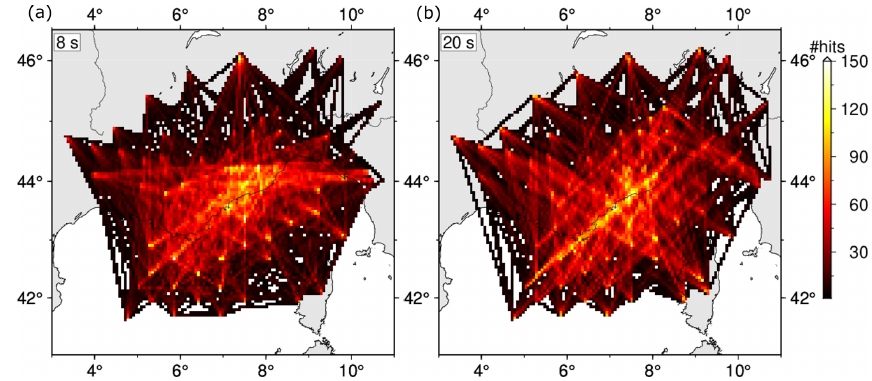
Figure 2. Hit count maps showing the ray coverage for ambient noise CCF pairs at 8s (a) and teleseismic CCF pairs at 20s (b) . The grid cells have a size of 5km ×